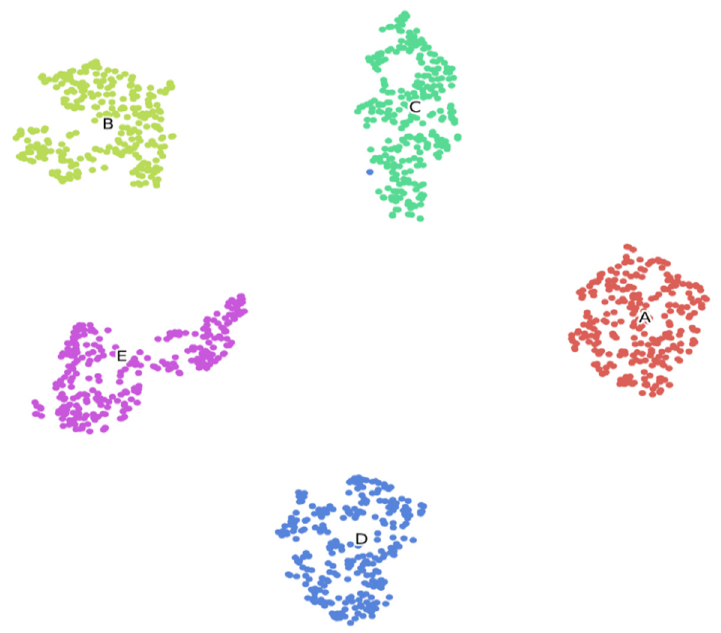
Figure 9. Two-dimensional t-SNE visualization of the learned representations of the Epileptic-Net model for the 10% data of the entire dataset.